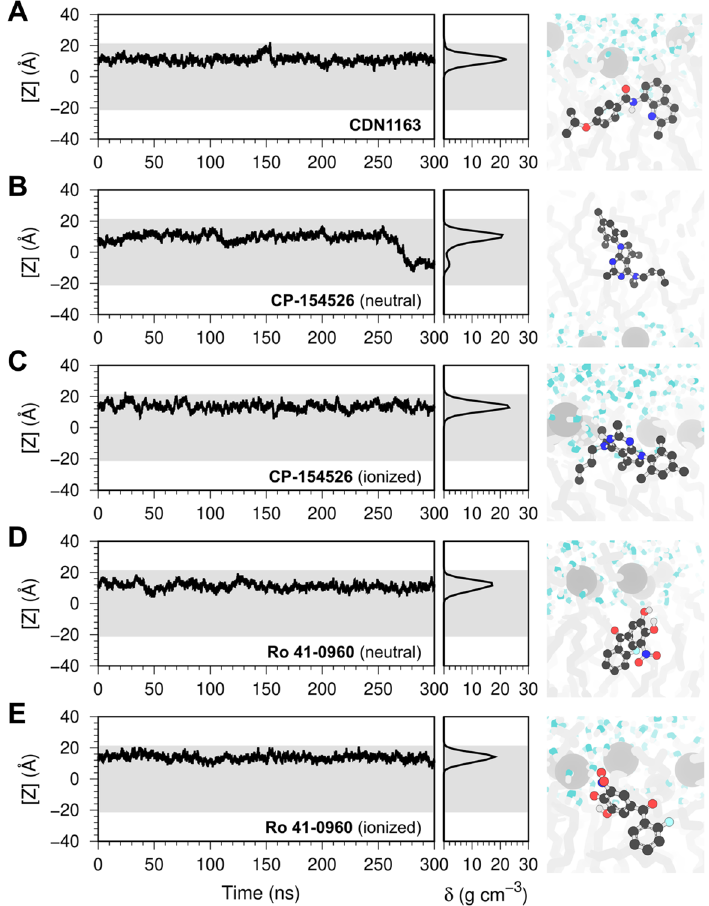
Figure 3. Single-molecule atomistic simulations of ligand–membrane interactions. The plots represent the position of a single molecule of ( A ) CDN1163, ( B , C ) CP-154526, and ( D , E ) Ro 41-0960 bound to a solvated POPC membrane. We show the time-dependent position of the molecule along the z-axis of the lipid–water system (left), the relative density (δ) profile of the molecules in the lipid bilayer (center), and the orientation of the molecules in the lipid bilayer extracted at the end of the trajectories (right). In all plots, the shaded area represents the location of the lipid bilayer. The small molecules are shown as ball and stick representation; lipid headgroups and tails are shown as light gray spheres and sticks, respectively; water molecules are shown as white and blue